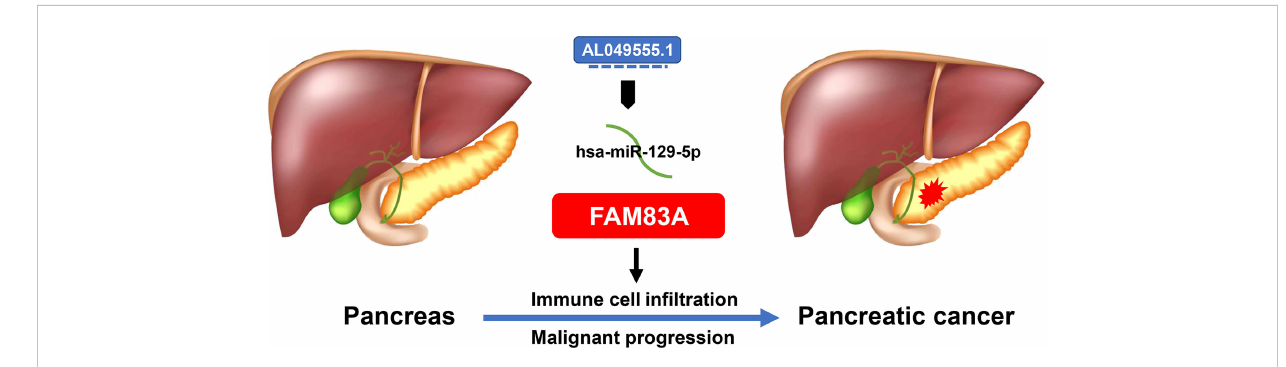
FIGURE 8 The model of AL049555.1/hsa − miR − 129 − 5p/FAM83A axis in tumorigenesis of PC.